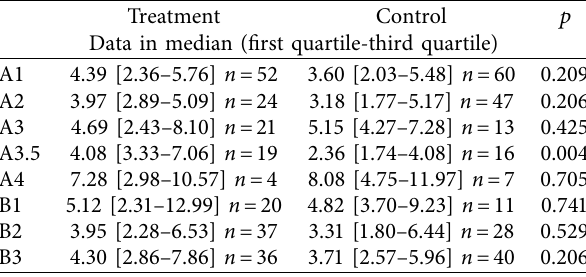
Table 5: Δ E values for each shade of the treatment group and the control group ( n �